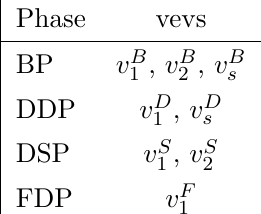
Table 4 . Naming convention for the vevs at stationary points of di(cid:11)erent phases. Only non-zero vevs are